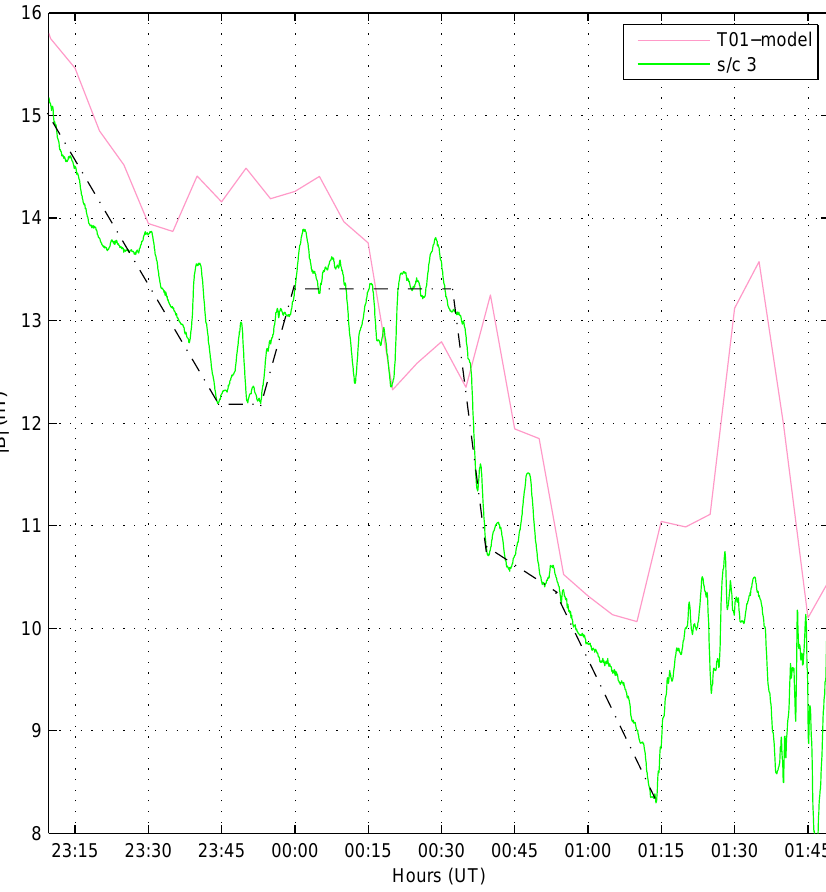
Fig. 6. Absolute magnetic field strength measured by s/c 3 (green curve) and from the T01 model at the location of s/c 3. The dash-dotted line is our interpretation of the large scale behaviour of the magnetic field